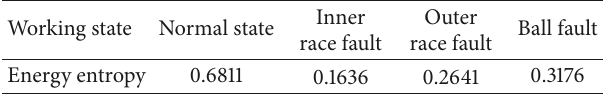
Table 2: Energy entropy of each bearing state for the first sample. Working